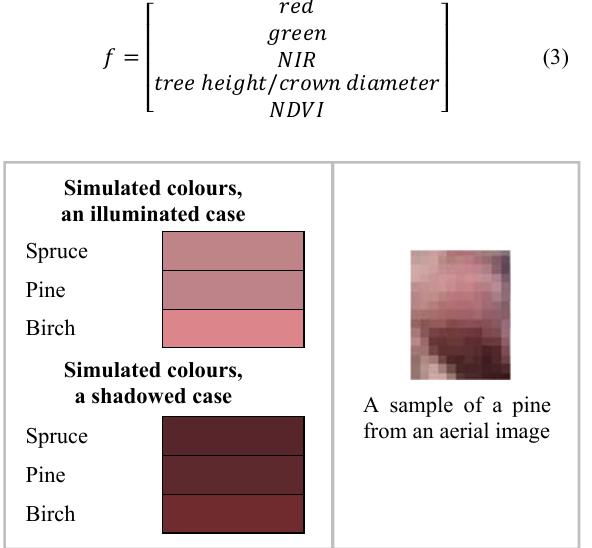
Figure 3. Simulated colour values and a sample of a pine taken from an aerial image.